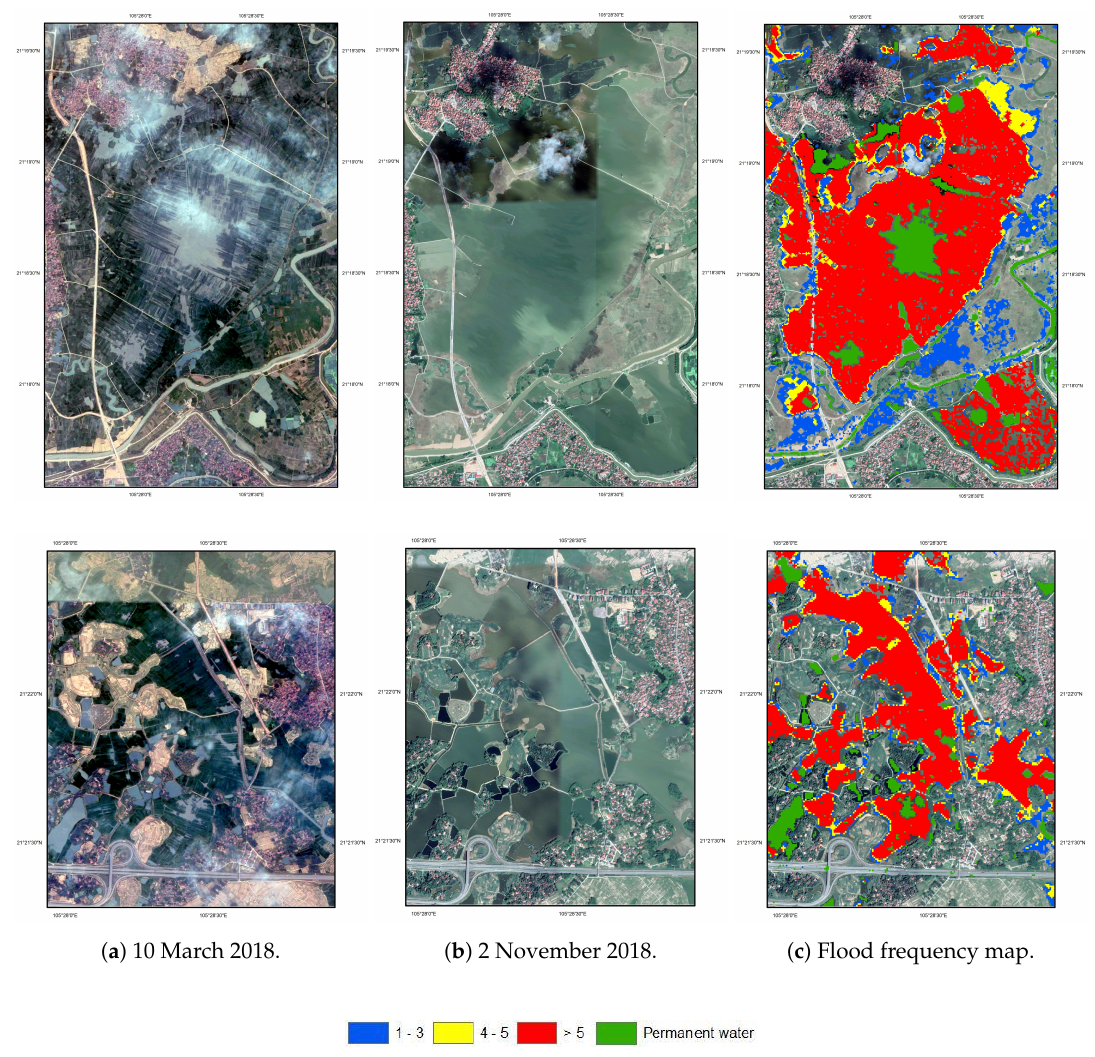
Figure 12. Visual inspection of heavily affected rice areas caused by prolonged inundation after the storm Son-Tinh in Lap Thach, Vinh Phuc (Figure 11, the A area) after the Son-Tinh happened. Column ( a ) Two Google Earth image scene on 10 March 2018—(dry season), Column ( b ) Two Google Earth Image scenes on 2 November 2018, Column ( c ) A combined scene of flood frequency map and Google Earth image on 2 November 2018 (flooding